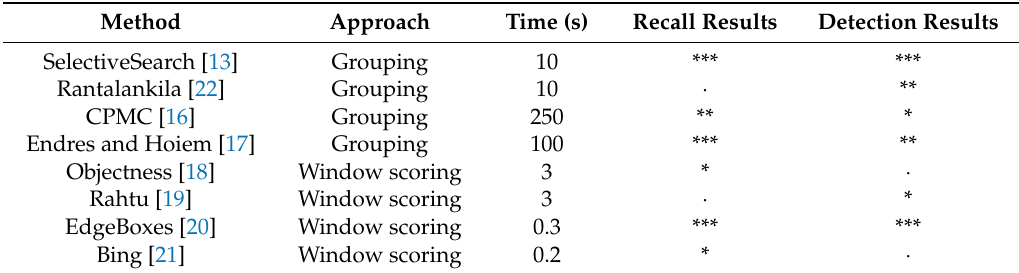
Table 1. Comparison of different region proposal methods.